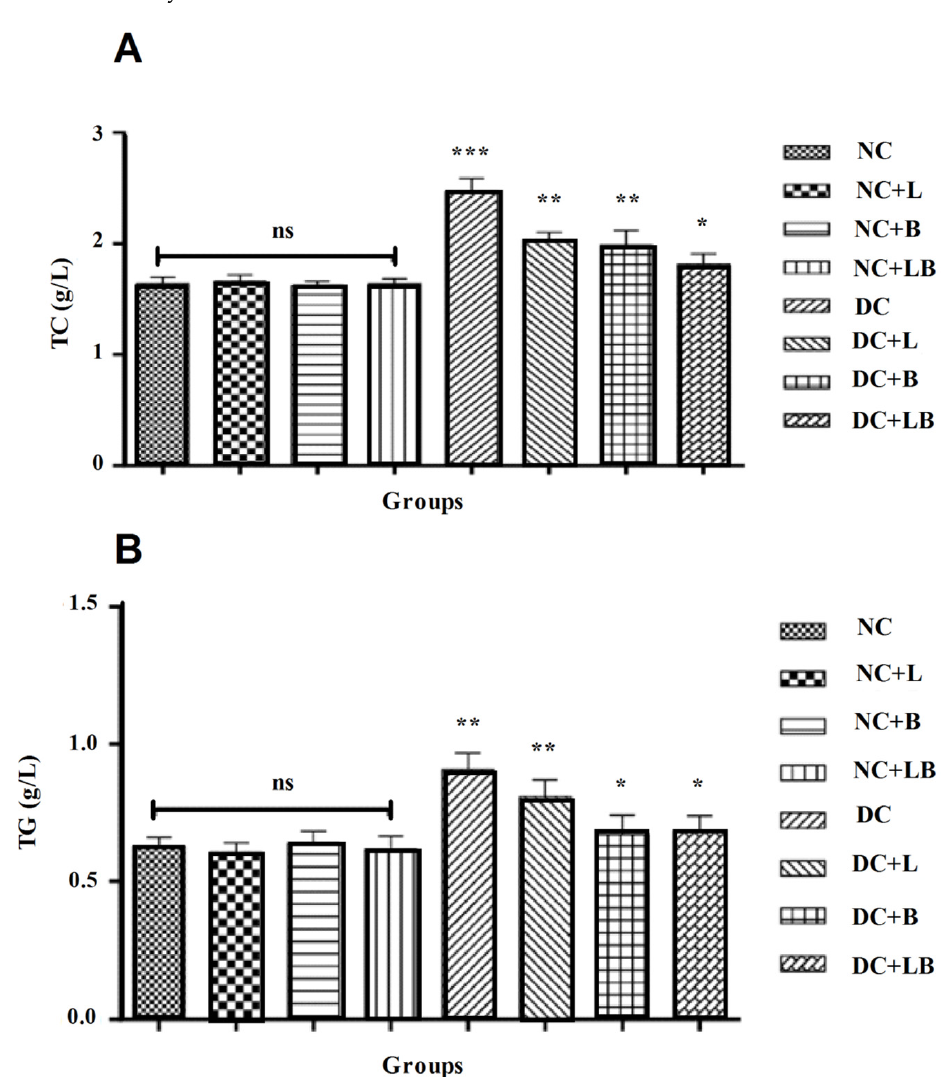
Figure 1. Impact of the daily administration of leaf and bud extracts and their combination on cholesterol levels ( A ) and triglycerides ( B ) of different groups. Data are presented as mean ± SD; statistical analysis was performed between the normal control group (NC) and all remaining groups. (The significance started at * p < 0.05; ** p < 0.01; *** p <